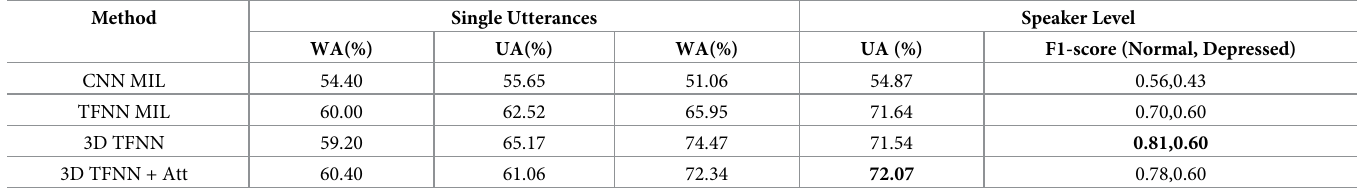
Table 2. Recognition accuracies in terms of Weighted Accuracy (WA) and Unweighted Accuracy (UA) and F1-scores for different tensor based techinques for test set of Daic-Woz dataset.